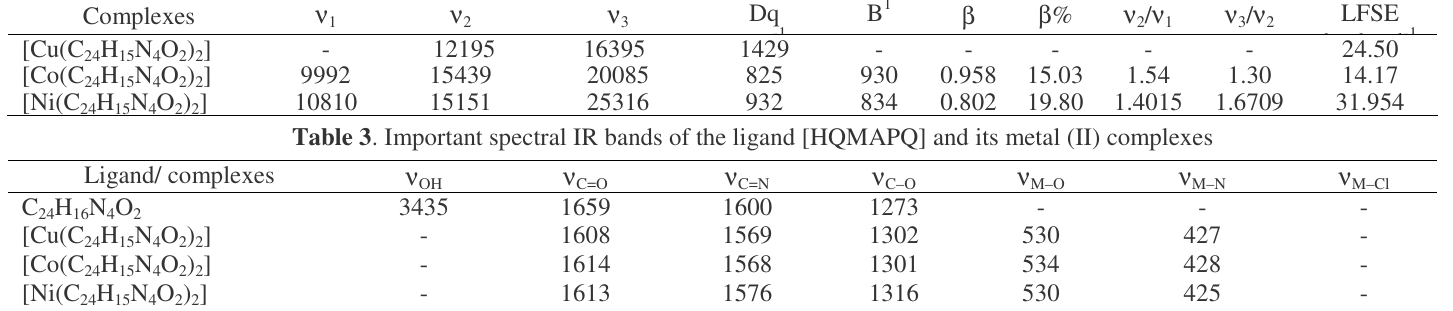
Table 2 . Electronic spectral data and ligand field parameters of Cu(II), Co(II) and Ni(II) quinazoline complexes